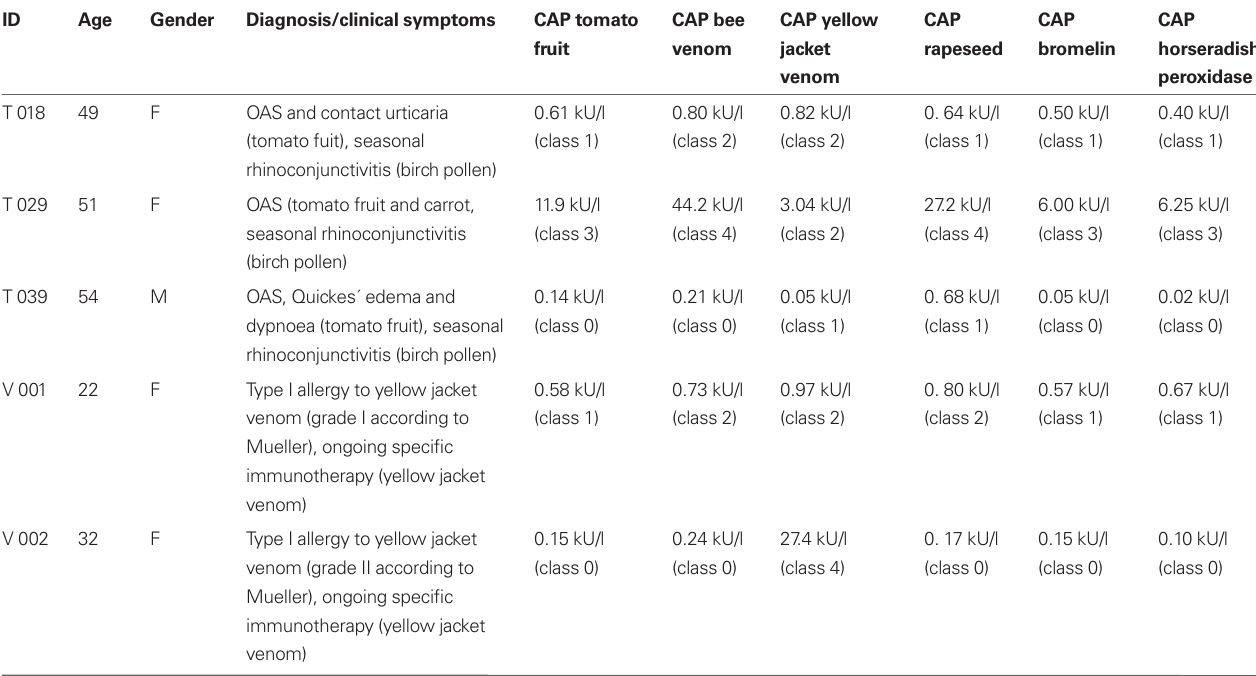
Table 1 | Characterization of patients (history, allergic symptoms, specific ige (CAP FeiA